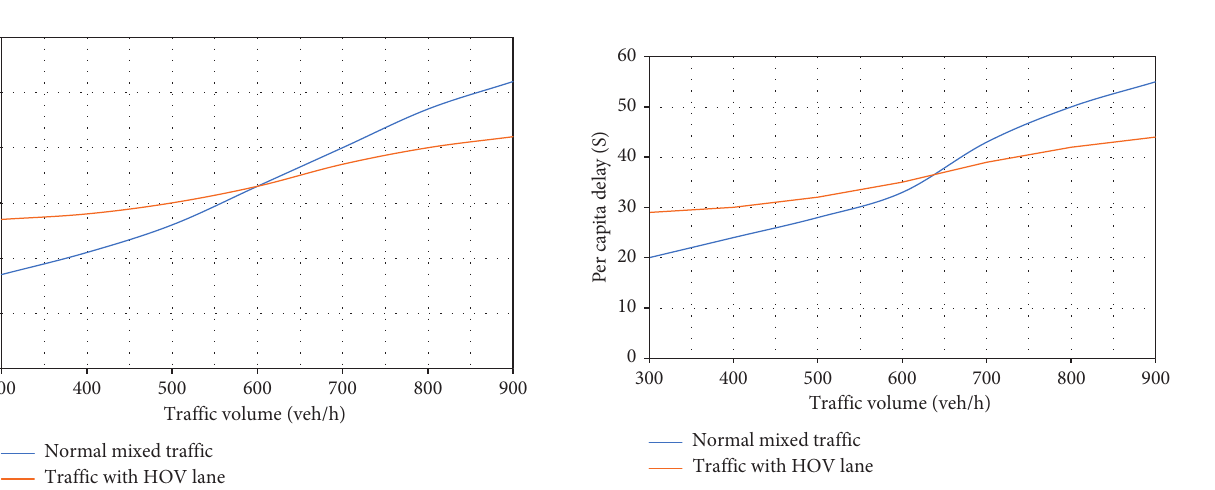
Figure 2: Bar graph of different carpooling passenger numbers.